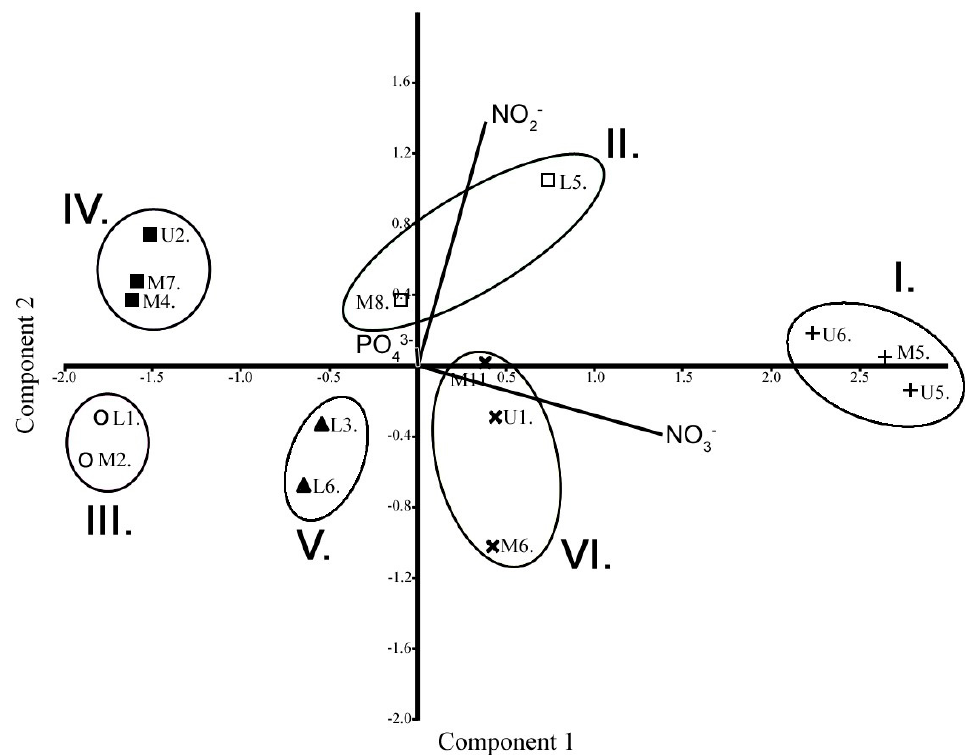
Figure 3. Results for the summer period of the principal component analysis applied to the physical and chemical variables at the sampling points of the sampling area. Group I: cross ( + ). Group II: empty square ( □ ). Group III: empty circle (o). Group IV: full square ( ■ ). Group V: full triangle ( ▲ ). Group VI: rotated cross (x). Upper Area: U1 − U9; Middle Area: M1 − M11; Lower Area: L1 − L6.